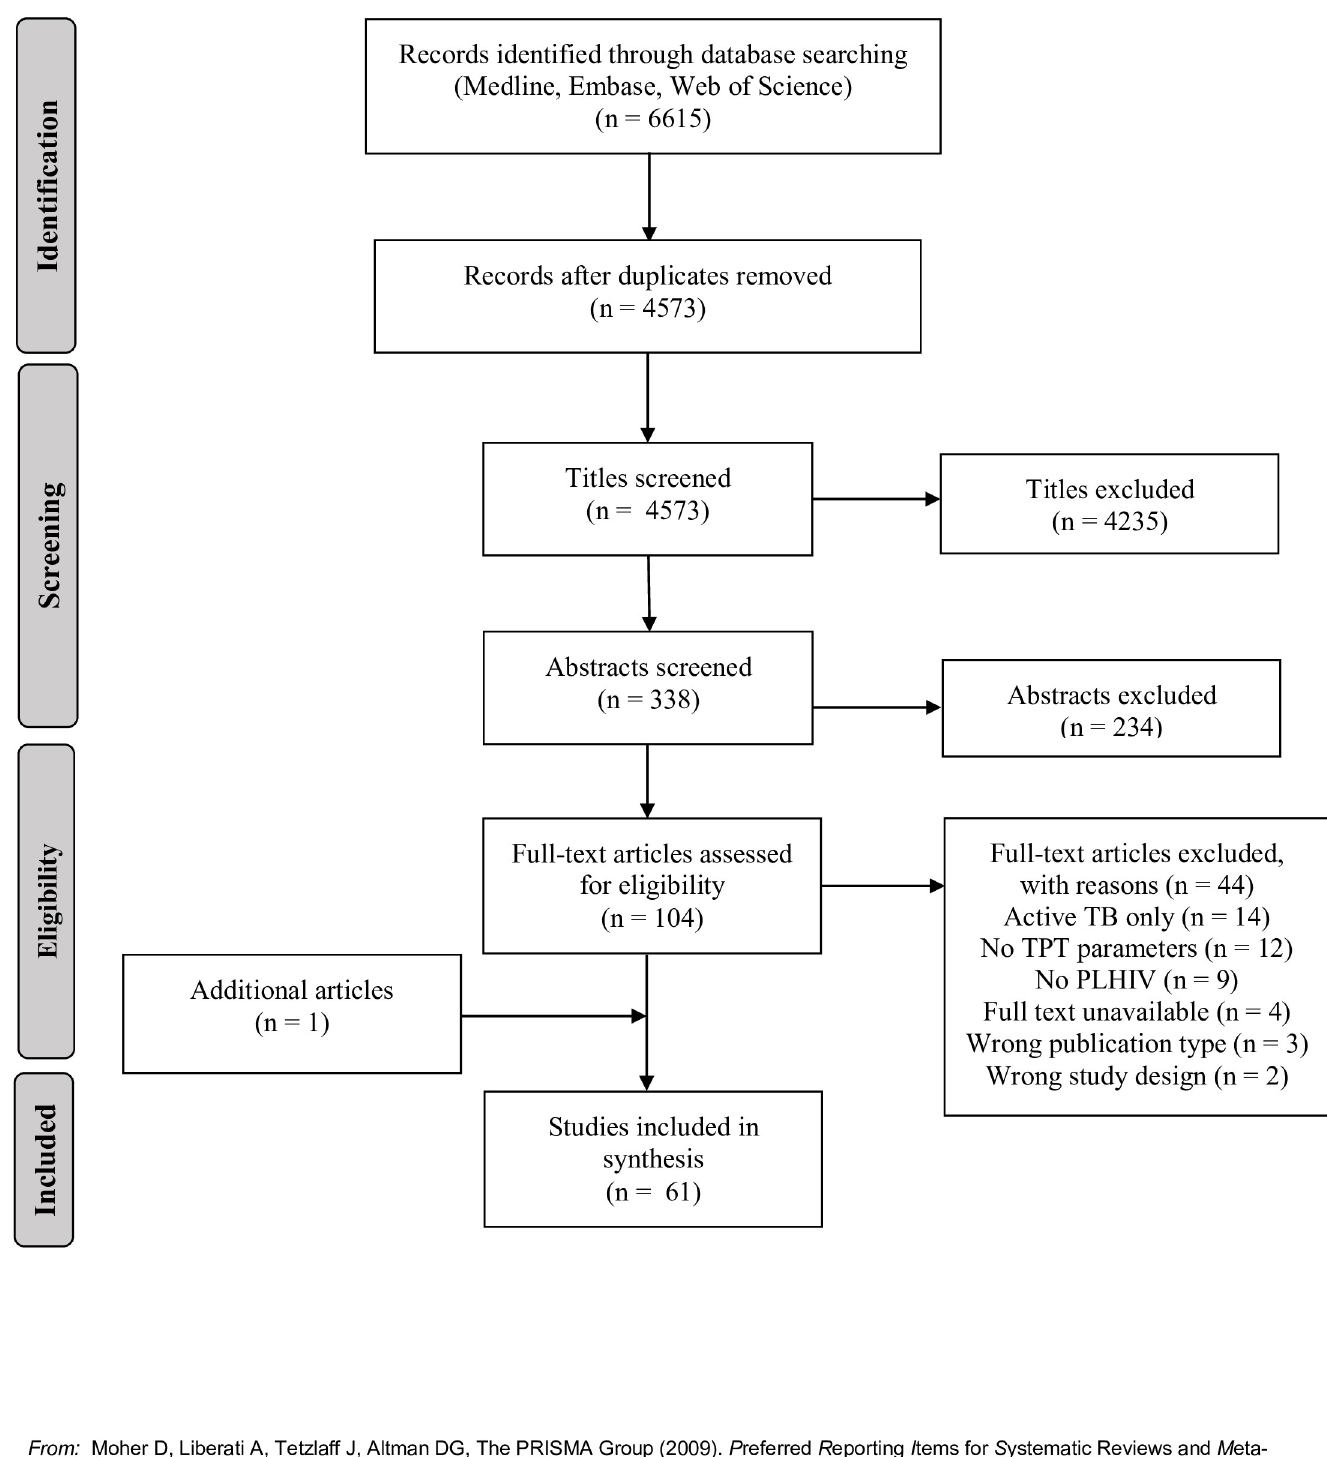
Fig 1. Selection of included studies. PLHIV, people living with HIV; TB, tuberculosis; TPT, tuberculosis preventive therapy. Citation: Moher D, Liberati A, Tetzlaff J, Altman DG, The PRISMA Group. Preferred Reporting Items for Systematic Reviews and Meta-Analyses: The PRISMA Statement. PLoS Med. 2009;6(7):e1000097. doi: 10.1371/journal.pmed1000097. https://doi.org/10.1371/journal.pmed.1003712.g001 PLOS Medicine| https://doi.org/10.1371/journal.pmed.1003712 September 14,